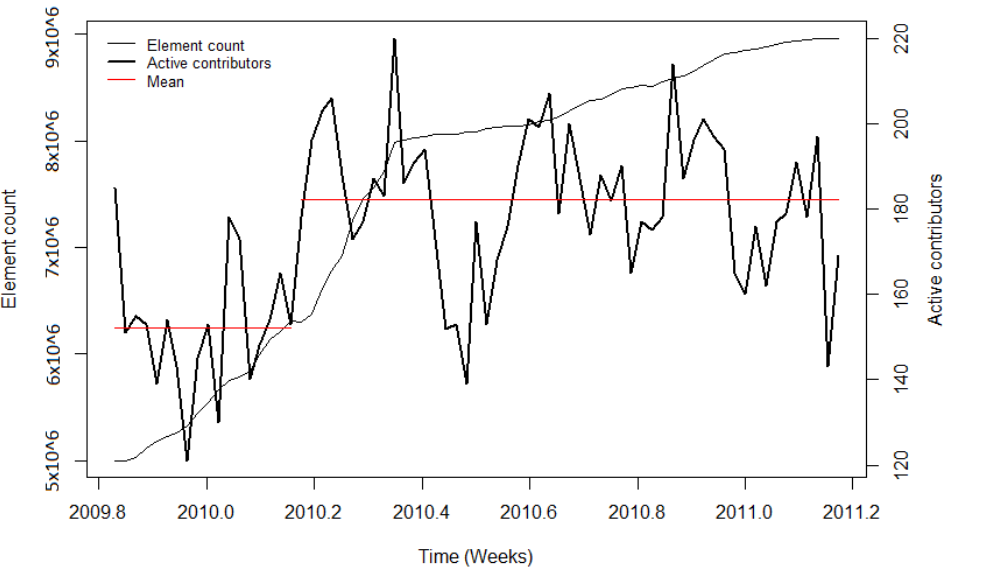
Figure A2. Contributor activity during the 3dShapes import.